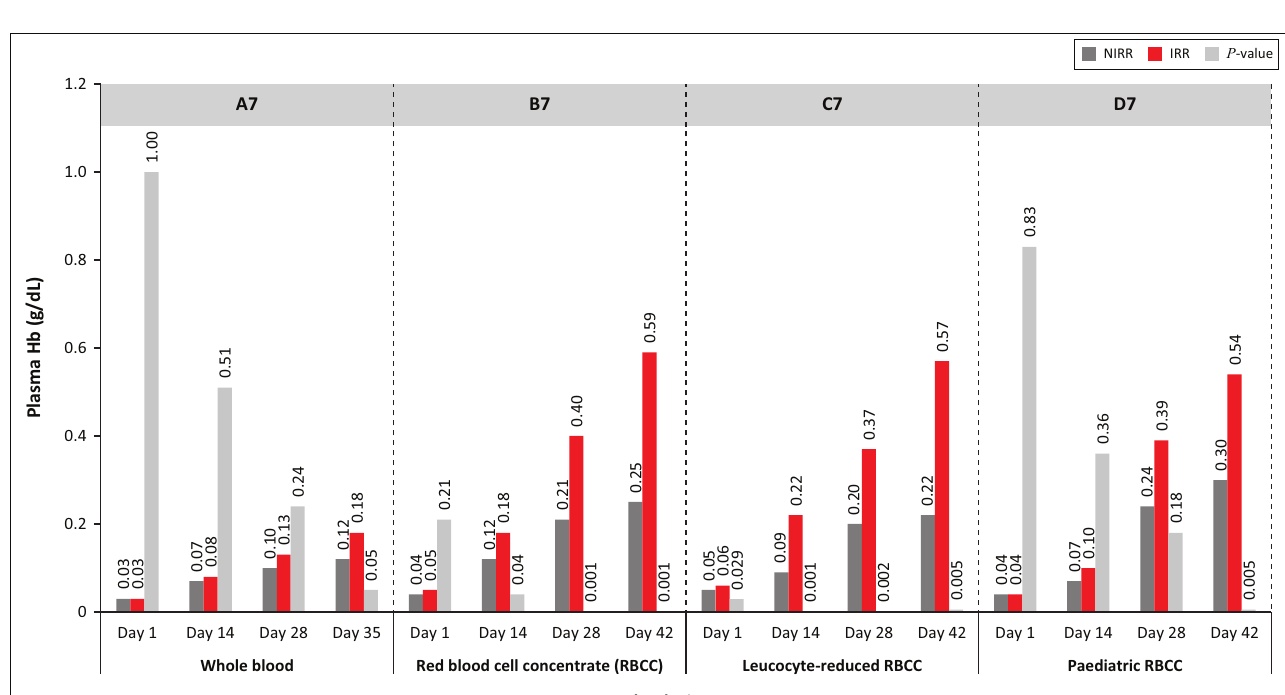
FIGURE 5: Percentage plasma haemolysis levels.